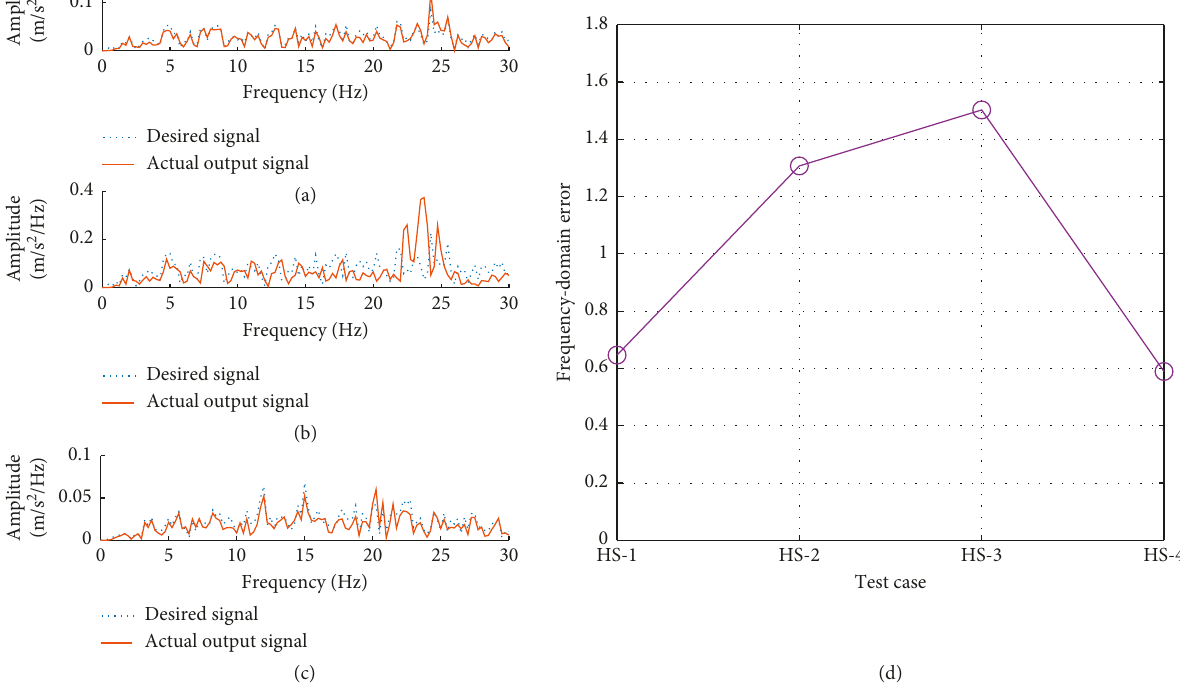
Figure 17: Desired signal and actual output signal frequency-domain comparison and error. (a) Case HS-1; (b) case HS-3; (c) case HS-4; (d) frequency-domain error of test